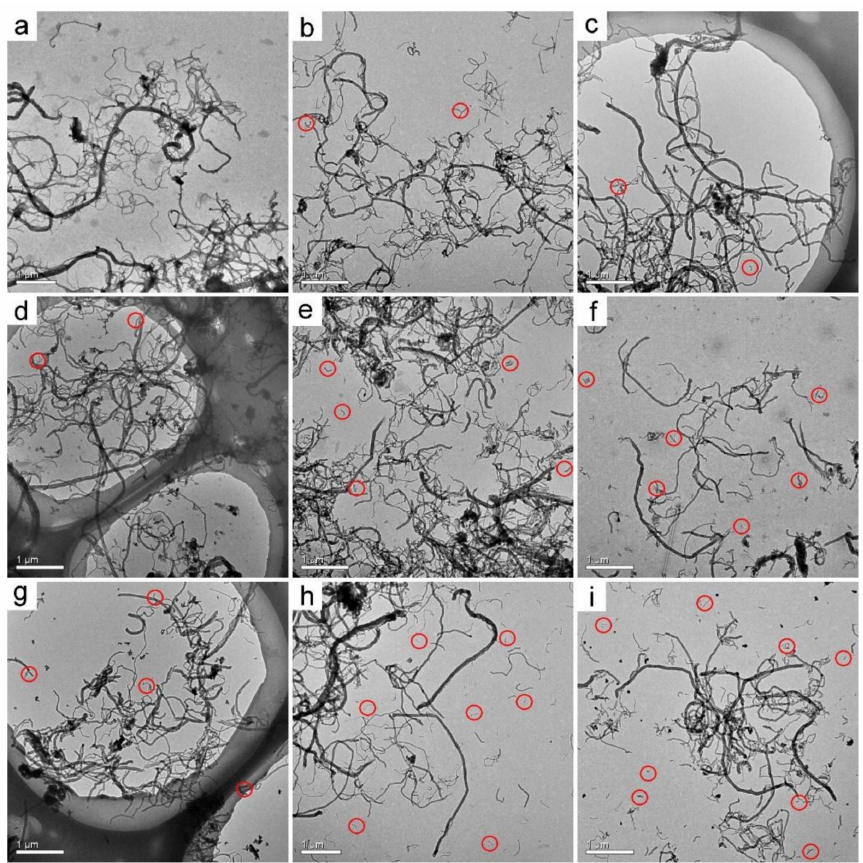
Figure 2. TEM images of oxidized MWCNTs (o-MWCNTs) after the incubation with P. chrysosporium . ( a ) As-prepared o-MWCNTs; ( b ) wrapped o-MWCNTs at 3 d; ( c ) wrapped o-MWCNTs at 7 d; ( d ) wrapped o-MWCNTs at 14 d; ( e ) wrapped o-MWCNTs at 30 d; ( f ) precipitated o-MWCNTs at 3 d; ( g ) precipitated o-MWCNTs at 7 d; ( h ) precipitated o-MWCNTs at 14 d; ( i ) precipitated o-MWCNTs at 30 d. Shortened o-MWCNTs are circled in